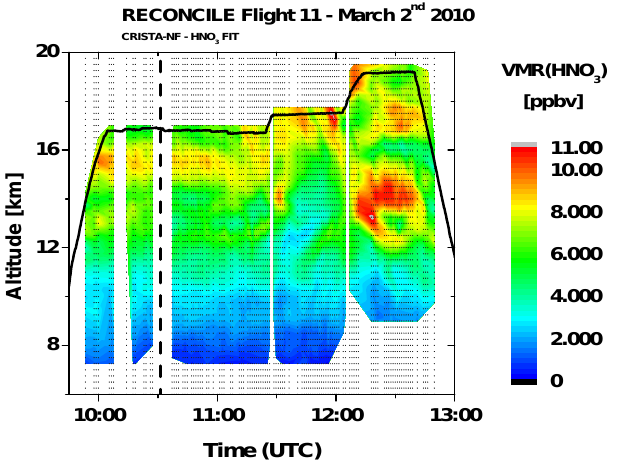
Fig. 20. Vertical cross-section of CFC-11 along flight track derived from MIPAS-STR measurements (compare Fig.